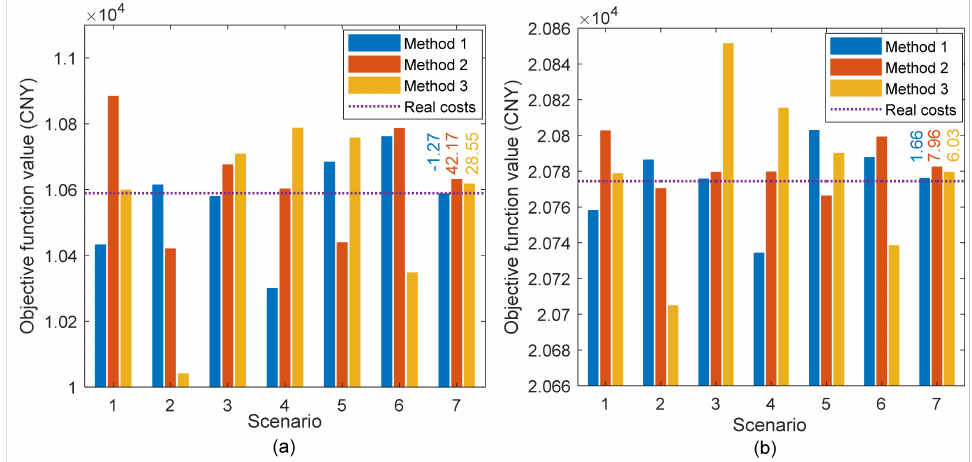
Figure 12. Comparison of Results in Different Scenarios ( a ) Summer ( b )